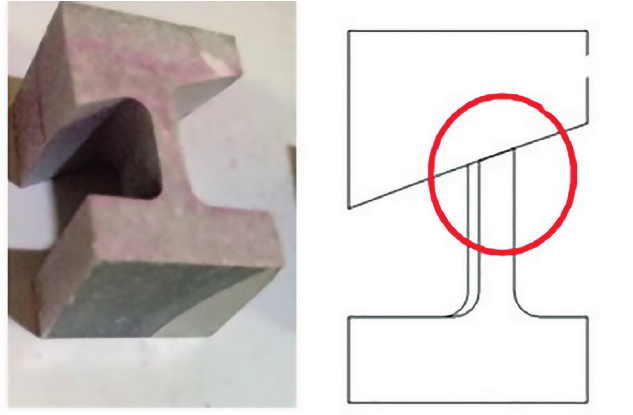
Figure 7. Segment ready for surface preparation and inspection.